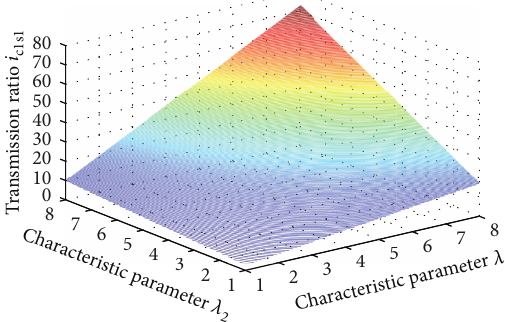
Figure 2: Relationship between transmission ratio and characteris- tic parameters of planetary gear train.